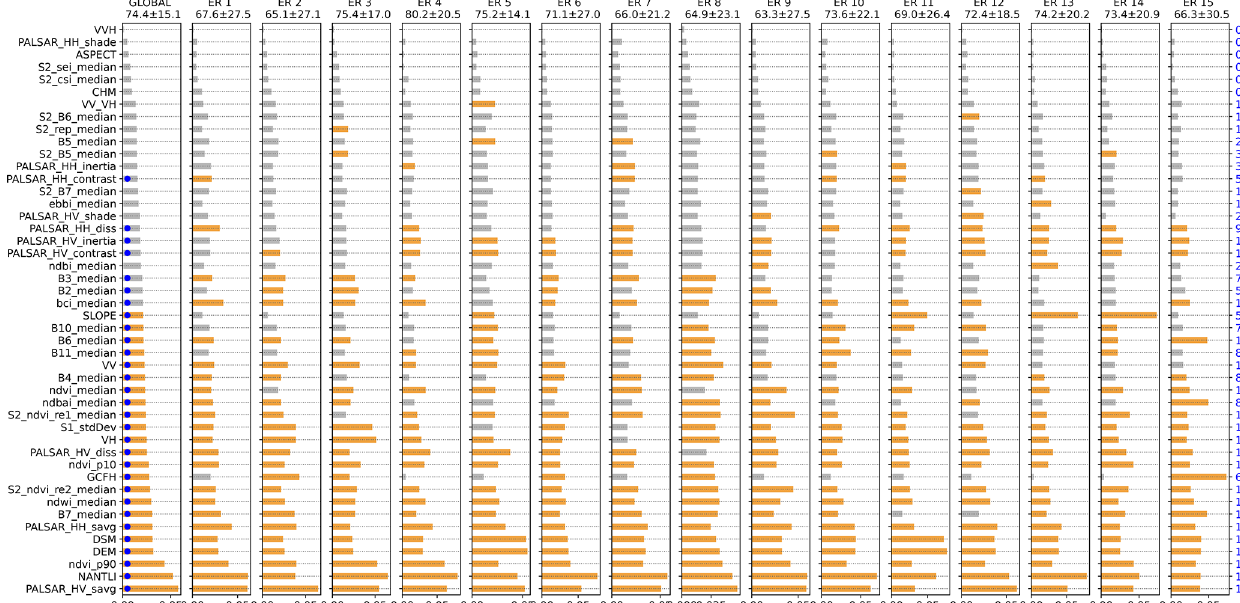
Figure F1. Feature importance ranking for the globe and per urban ER. Bars in bright orange depict the input features (per spatial unit) that belong to the top 50% of the most important variables. Numbers on top depict the overall accuracy ± the standard deviation (%). Blue numbers on the right-hand side describe how often an input feature belongs to the top half of the most important features. Features with a value ≥ 5 are used in pathway 2 to create the global LCZ map and are indicated by the blue dot in the global panel on the left. These features are described in more detail in Table